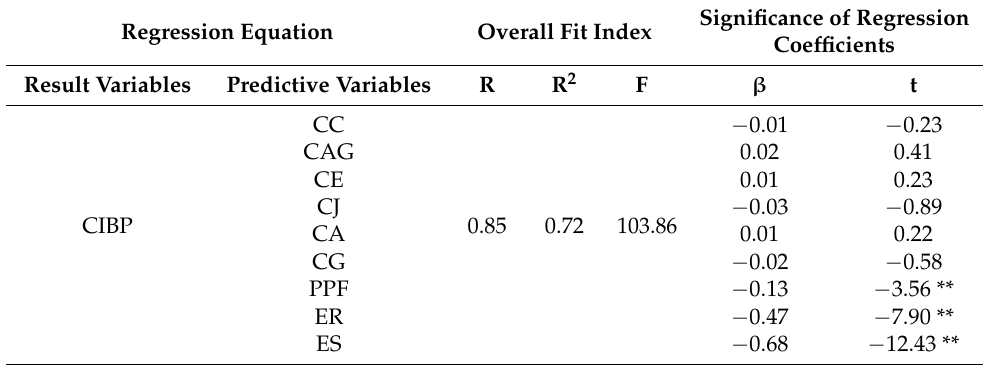
Table 3. Regression analysis of internalizing behavior problems. Regression